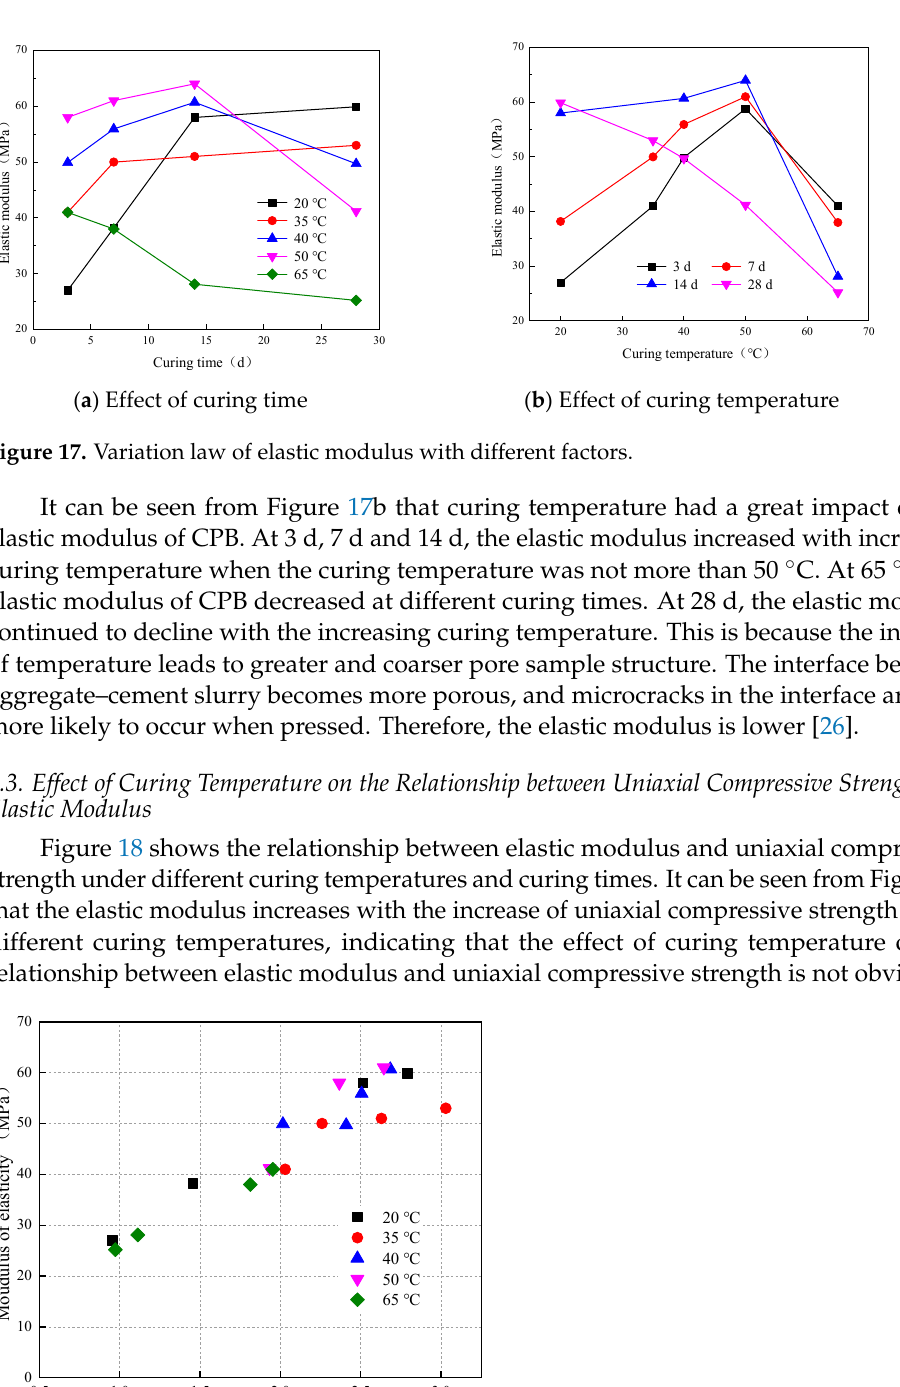
( e ) 65 °C Figure 16. Stress-strain curves of CPB at different times. 4.2. Effect of Curing Temperature on Elastic Modulus The effect of different curing temperatures and curing times on the elastic modulus is shown in Figure 17. It can be seen from Figure 17a that curing time had a great impact on the elastic modulus under different curing temperatures. At 20 °C and 35 °C , the elastic modulus value gradually increased with increased curing time, and the increase at 20 °C was significantly higher than that at 35 °C . This is mainly because with the increased cur- ing time, the hydration reaction of cement was gradually completed, and the increase of hydration products led to the increase of hardness. At 40 °C and 50 °C , the elastic modulus gradually increased in 14d. However, after 14d, the elastic modulus began to decline, and the decline rate at 50 °C was significantly higher than that at 40 °C . The reason is that the higher temperature causes CPB to produce more pores, and leads to the decline of me- chanical properties. At 65 °C , the elastic modulus continued to decline with increasing curing time. The high temperature caused the rapid hydration reaction of CPB at the initial curing stage, which led to the incomplete hydration of the cement. At the same time, the high temperature will lead to the rapid gasification of moisture in the sample and result in a series of pores, which will affect the mechanical properties of CPB. It can be seen from Figure 17b that curing temperature had a great impact on the elastic modulus of CPB. At 3d, 7d and 14d, the elastic modulus increased with increasing